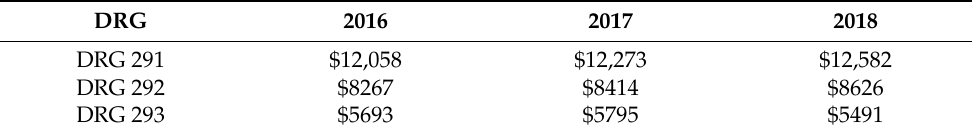
Table 4. Estimated total costs for heart failure by DRG in thousands, medical inflation rate method.